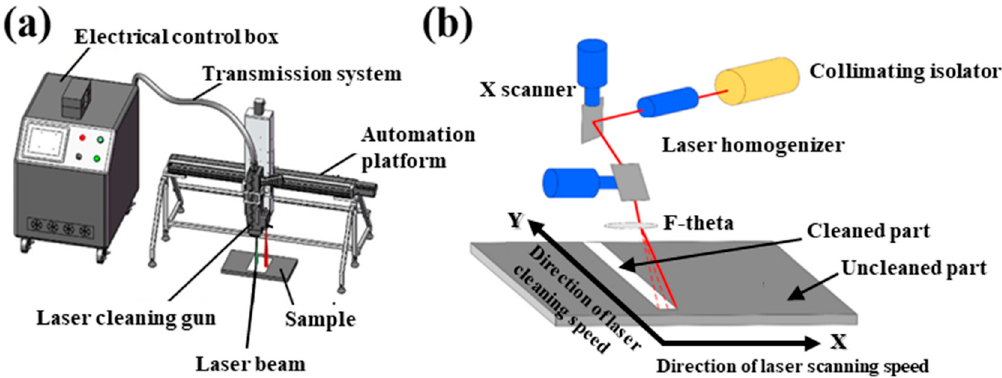
Figure2. Lasercleaningplatformsystem. ( a )automaticlasercleaningequipment; ( b )schematicdiagram Figure 2. Laser cleaning platform system. ( a ) automatic laser cleaning equipment; ( b ) schematic of cleaning operation [22]. diagram of cleaning operation [22]. Table 2. Main parameters of laser cleaning